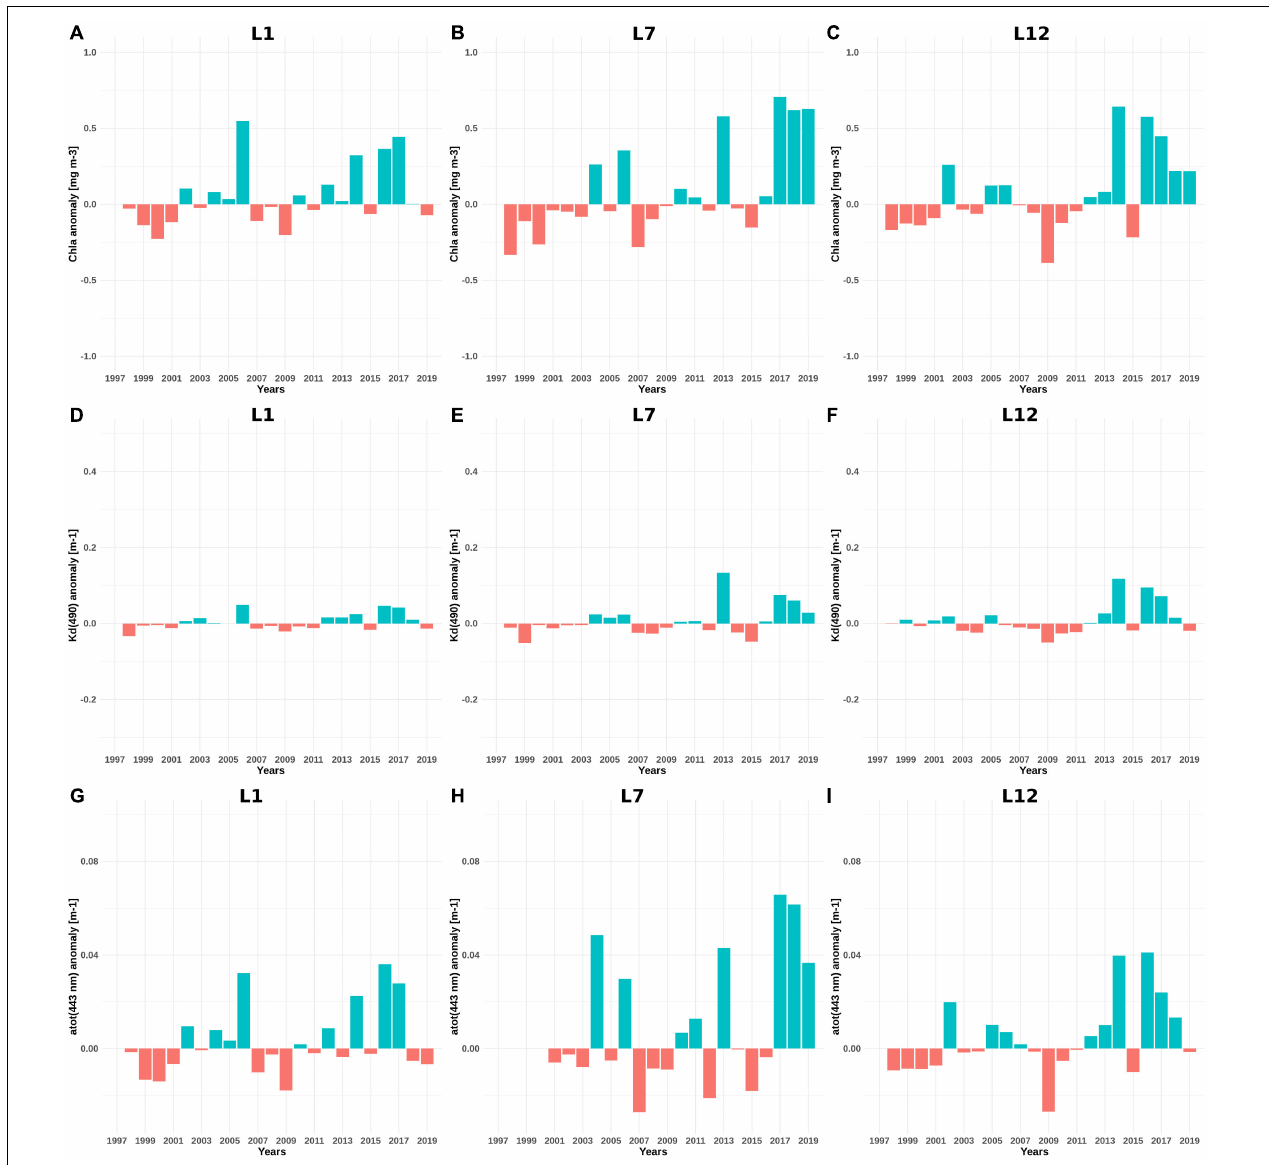
FIGURE 6 | Anomalies of the summer median values of Chla ( A–C – 1st row), K d (490) ( D–F – 2nd row), and a tot (443) ( G–I – 3rd row) each year in reference to the median value for all summer months 1997 – 2019 at locations: L1 (on the shelf at the similar latitude as the Kongsfjorden) ( A,D,G – left column), L7 (the central Isfjorden) ( B,E,H – middle column), and L12 (the entrance to the Hornsund fjord) ( C,F,I – right